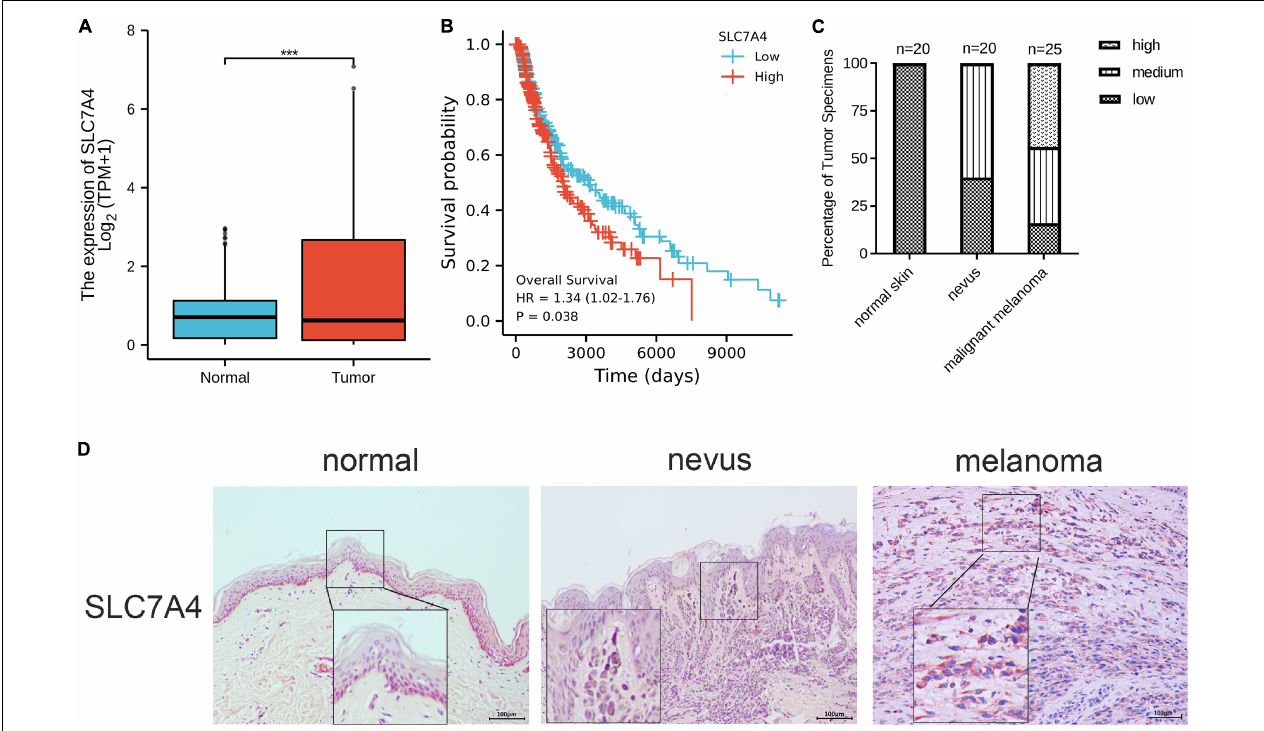
FIGURE 8 | The expression signature, prognostic value, and preliminary validation of solute carrier family 7 member 4 (SLC7A4). (A) The expression of SLC7A4 was higher in SKCM than in normal skin tissues. (B) The overall survival analysis of SLC7A4 in SKCM. (C,D) IHC staining demonstrated that the expressions of SLC7A4 staining increased with the progression of the disease. Normal skin tissues ( n = 20) showed the lowest expression, followed by benign nevi ( n = 20), and malignant melanoma tissues ( n = 25) showing the highest expression. IHC, immunohistochemistry. IHC stain, AEC, original magnification × 100, scale bar = 0.1 mm (inset, IHC stain, AEC, original magnification ×